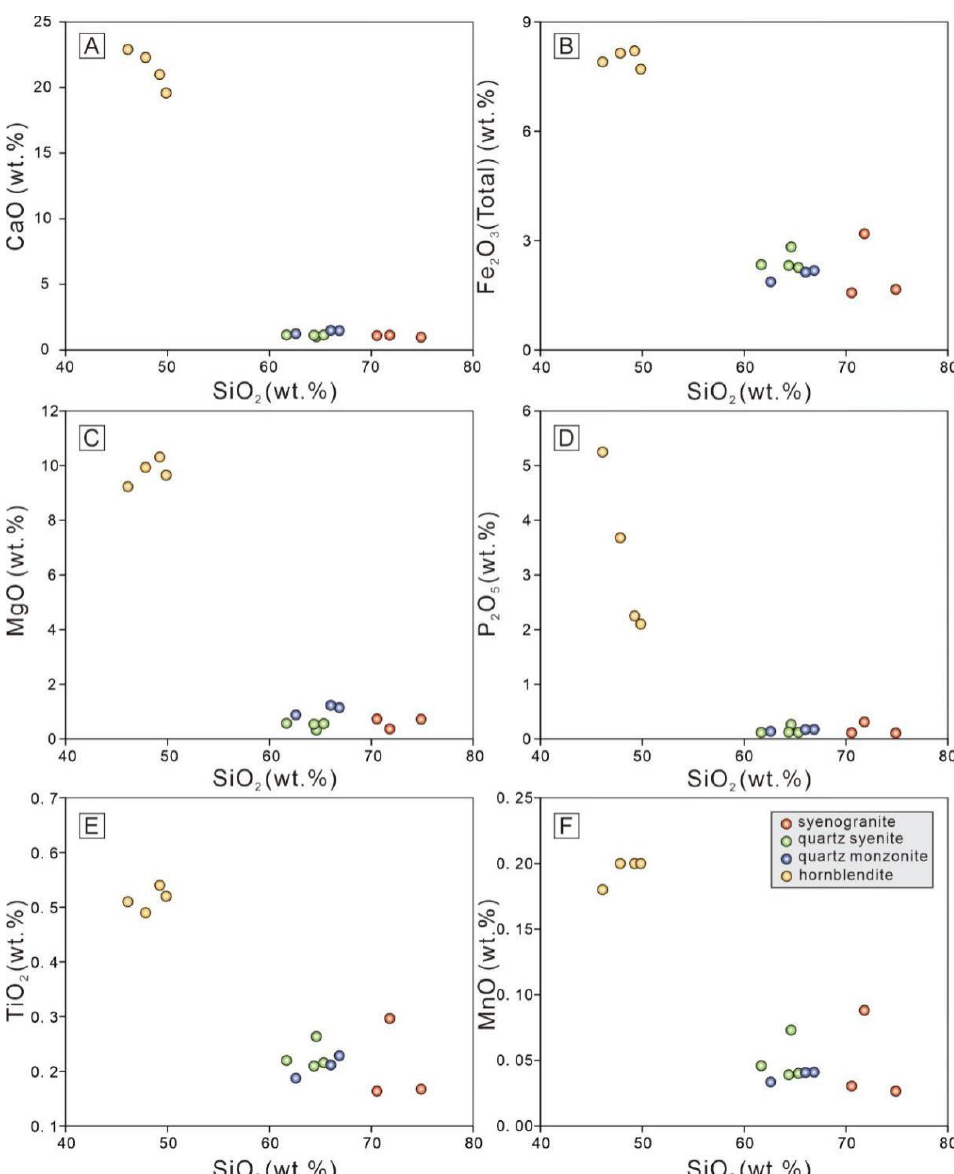
Figure 10. ( A – F ) SiO 2 vs. selected major elements showing variable trends for hornblendite, syenogranite, quartz syenite and quartz monzonite [8]. Major elements contents of hornblendite are taken from [7].